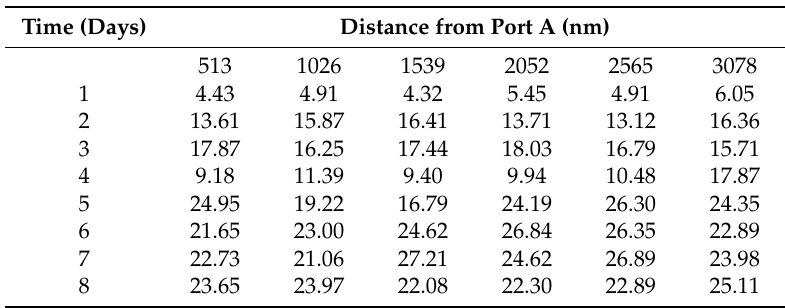
Table A2. Wind speed (in kn) as a function of time and space in Summer.